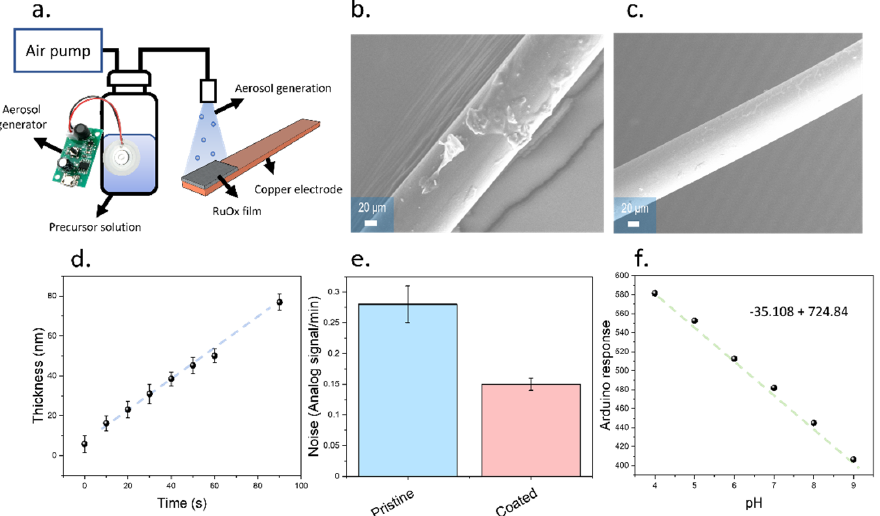
Figure 4. ( a ) Schematic representation of the aerosol system employed within the present work for the deposition of cellulose ‐ based coatings. The ultrasonic atomizer could be used to generate an aerosol which could be directed towards the sample by using an air pump. ( b ) SEM imaging of drop casted films onto copper substrates, evidencing the presence of a high surface roughness. ( c ). The deposition of the cellulose ‐ based coating using the aerosol method led to homogeneous films with controllable thicknesses. This method can also be applied to substrates with different morphologies and the final thickness of the films can be controlled. ( d ) Calibration plot obtained after fabricating cellulose ‐ based films onto the RuO x films using different deposition times. ( e ) Comparison graph of the noise rates obtained using the pristine sensors, only containing the RuO x films, and the cellulose ‐ based electrodes. The error bars indicate the standard deviation from triplicate measurements. ( f ) Calibration plot of the final devices containing RuO x and a cellulose ‐ based coating. The sensitivity achieved increased compared to the one achieved in the case of pristine RuO x .